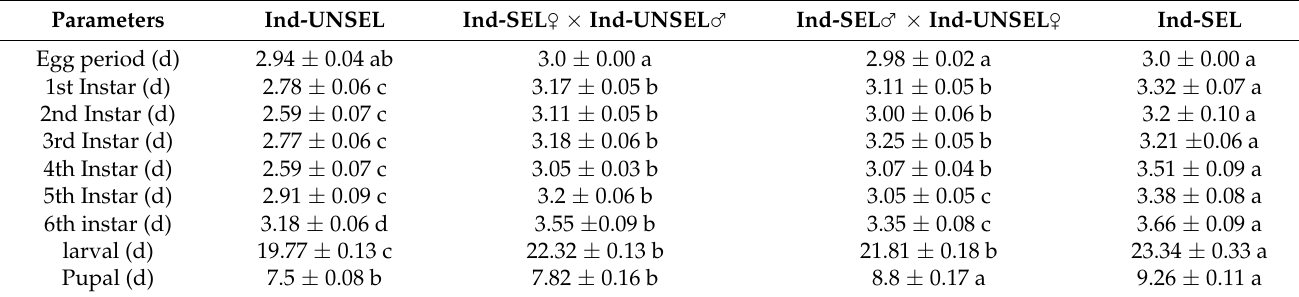
Table 5. Pre-Adults developmental time (Mean ± SE) of S. frugiperda